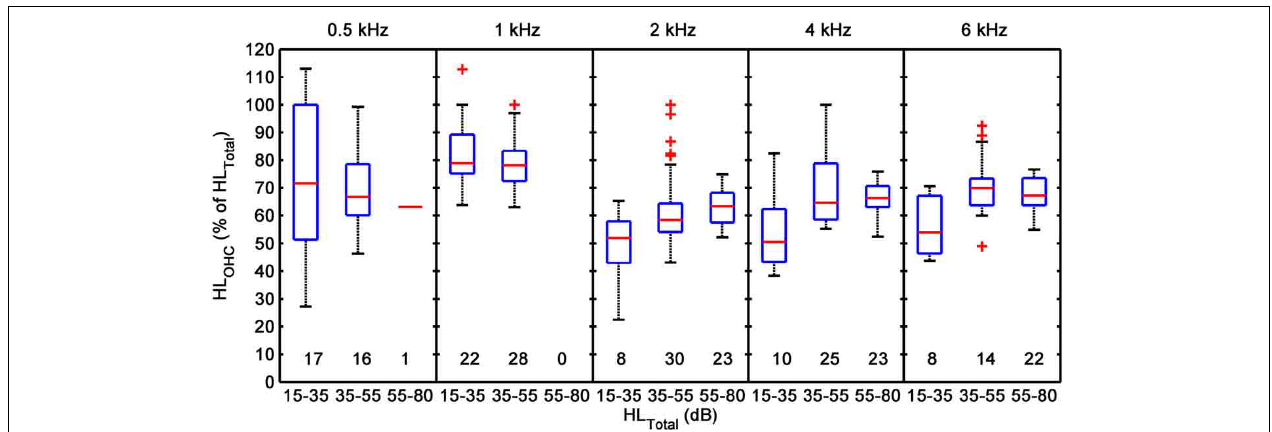
FIGURE 8 | Across-listener variability in the proportion of HL TOTAL explained by HL OHC . Each box plot illustrates distribution percentiles: the bottom and top lines in each box depict the first and third quartiles of the distribution; the band inside the box is the second quartile (the median); the lower and upper whiskers’ ends depict the 1 and 99% percentiles. Crosses ( + ) depict cases outside the latter percentiles.